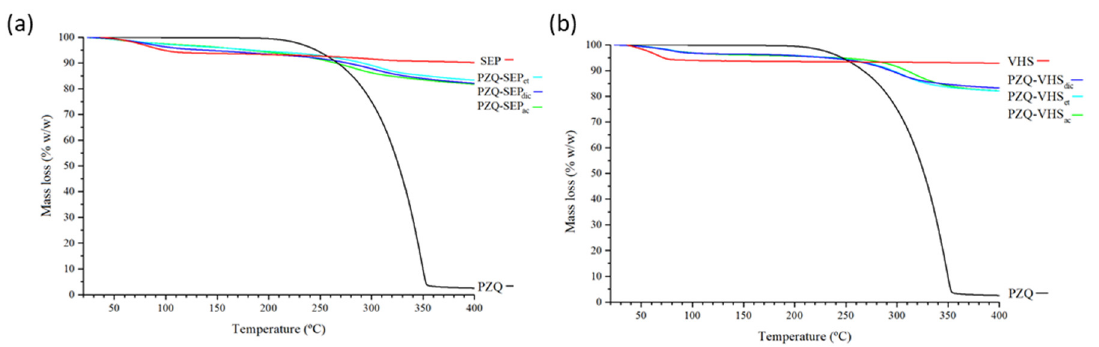
Figure 3. Thermogravimetric Analysis (TGA) profiles of the studied samples with sepiolite ( a ) and with montmorillonite ( b ).